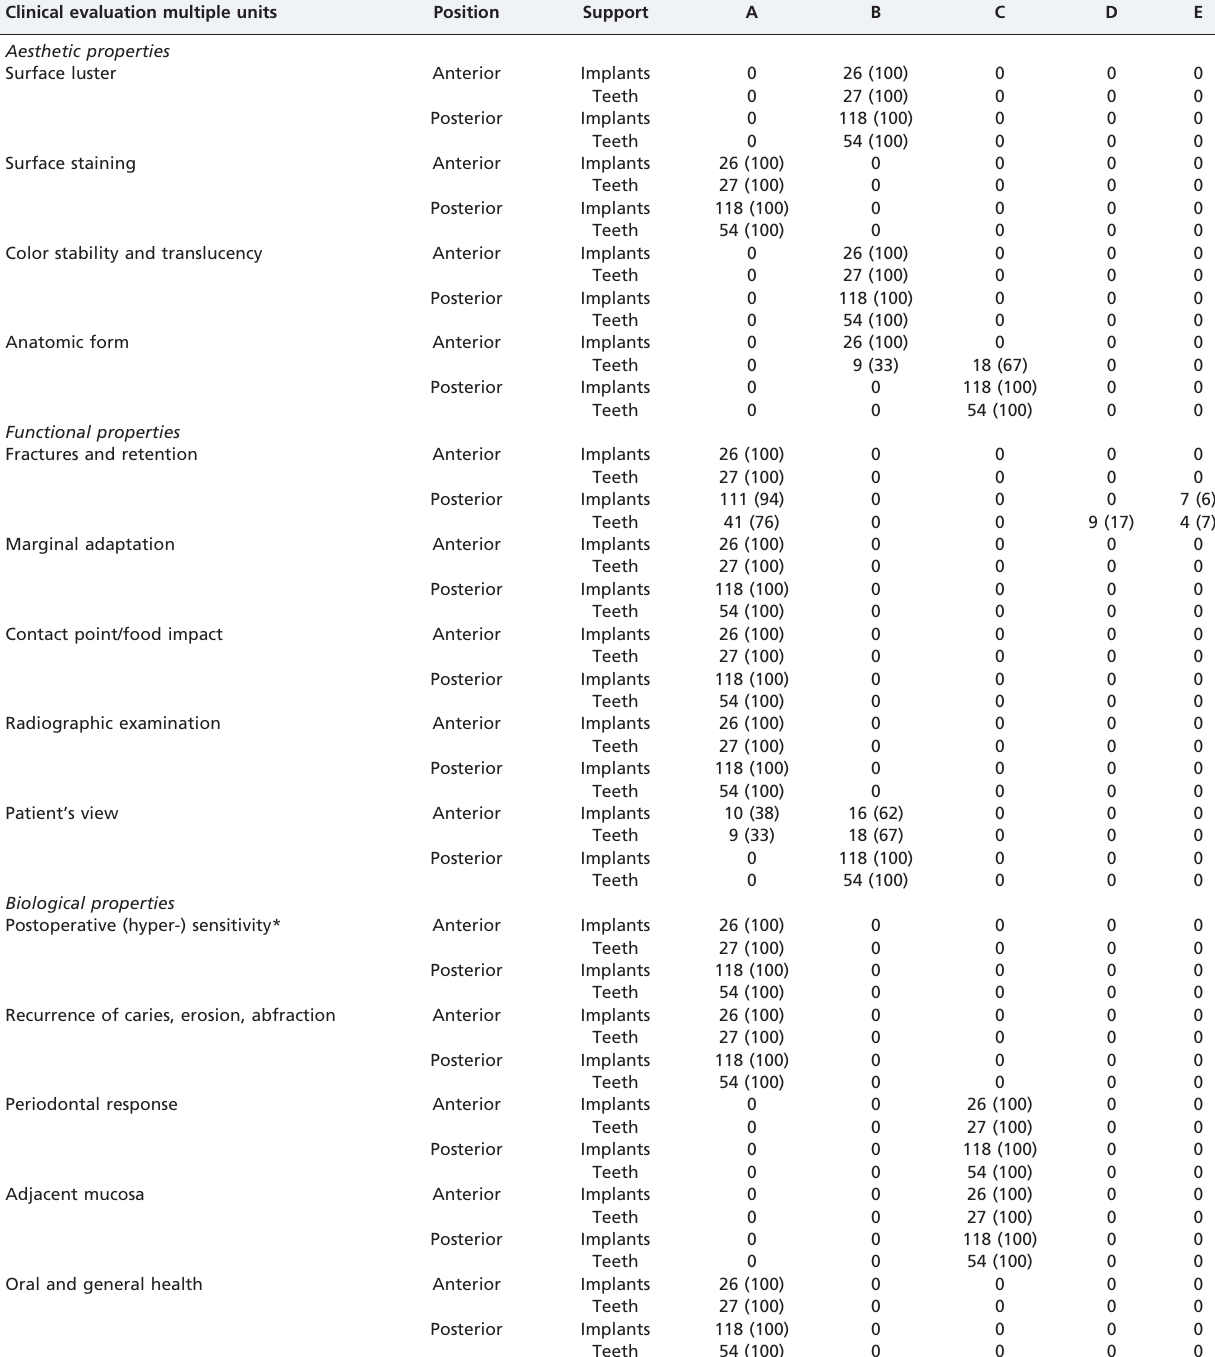
Table 4 - Clinical evaluation of the analyzed multiple-unit zirconia prostheses, according to Hickel et al. 22 at the 3-year follow-up examination. All values represent the number (and percentage) of